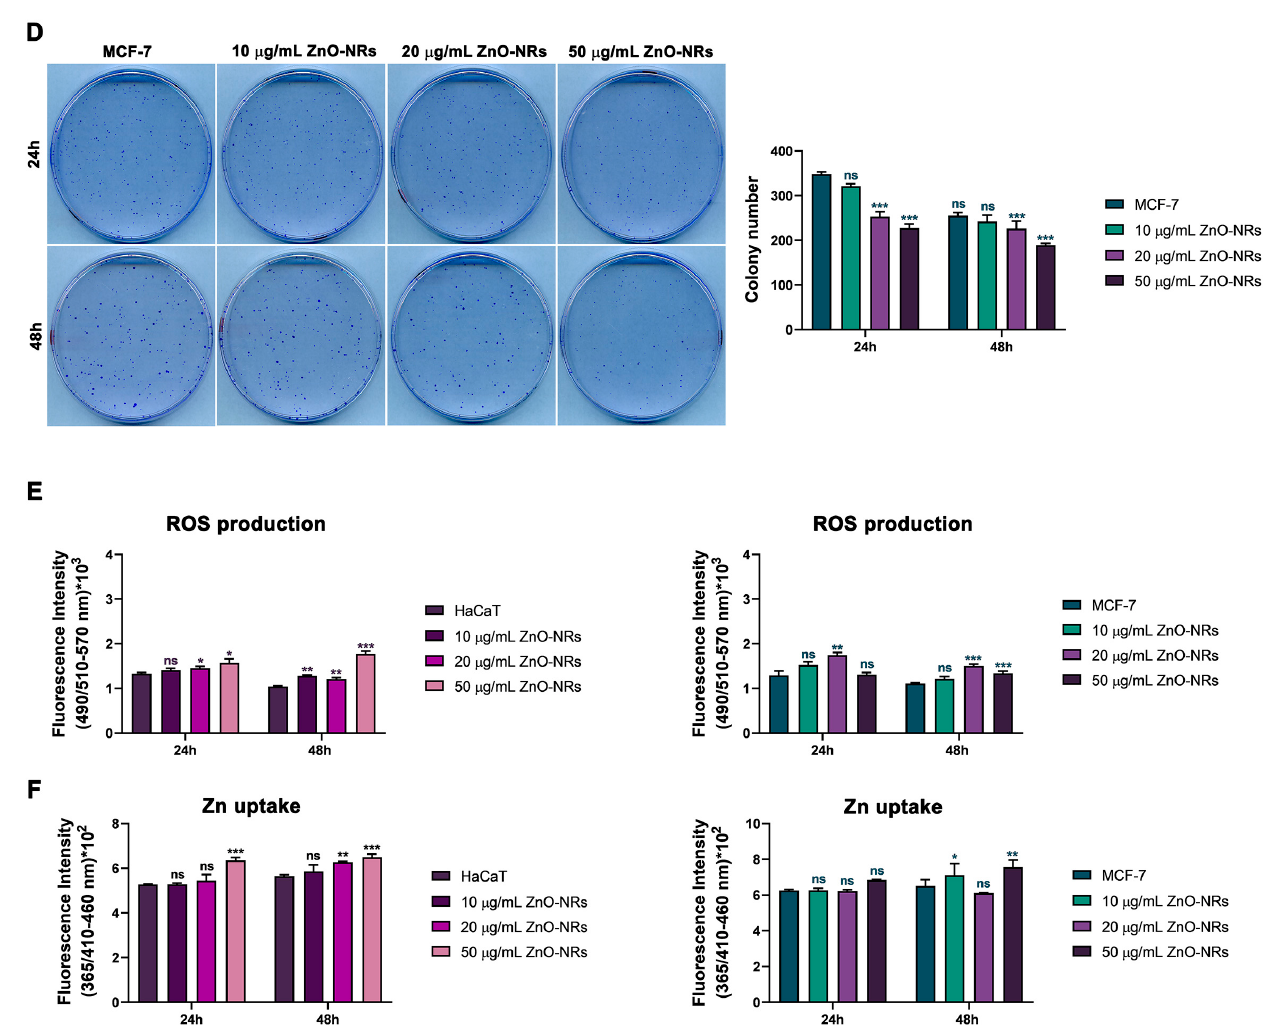
Figure 2. ZnO-NRs’ effects on HaCaT and MCF-7 cells. HaCaT and MCF-7 cells were either untreated or treated with the indicated ZnO-NR concentration for 24 and 48 h. The ncrease of ZnO-NR concentration caused a decrease ( A , B ) in cell viability and ( C , D ) clonogenicity ability. ( E ) Intracellular ROS measured in both cell lines after ZnO-NR treatment using 2 (cid:48) ,7 (cid:48) -dichlorofluorescin diacetate (DCFH-DA). ( F ) Intracellular Zn 2+ measured after ZnO-NR treatment using Zinquin. Experiments were repeated three times. * p < 0.05, ** p < 0.01, and *** p < 0.001. ns, not signi fi cant.